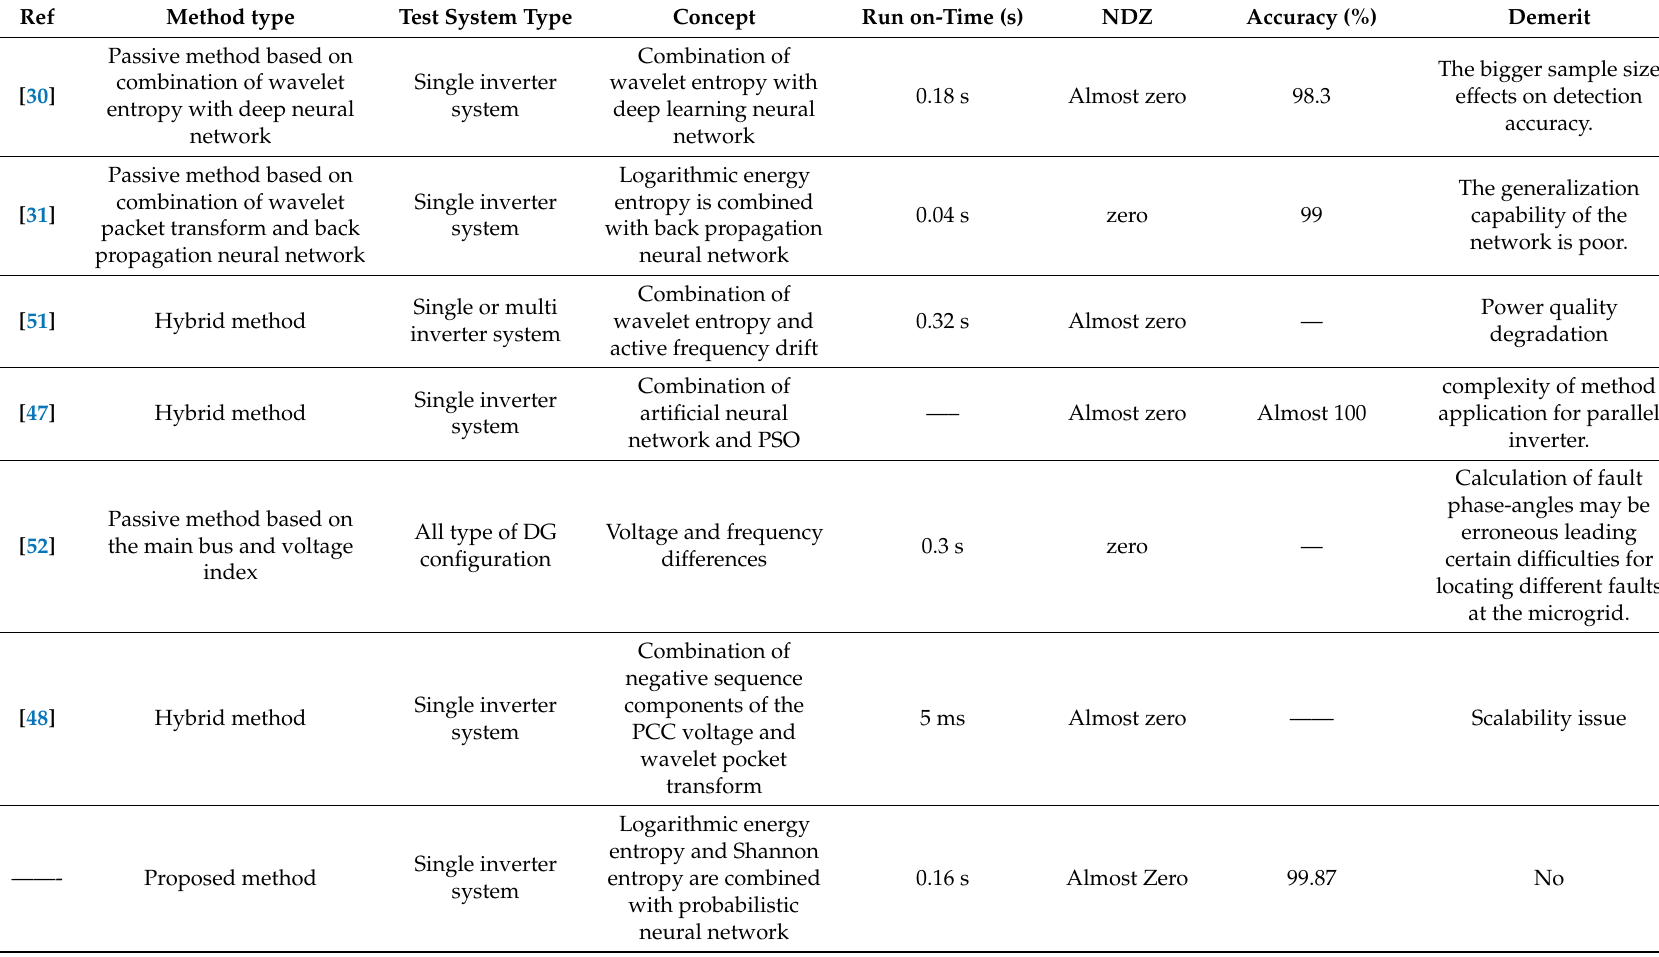
Table A2. Comparison between the proposed method and other recent islanding detection